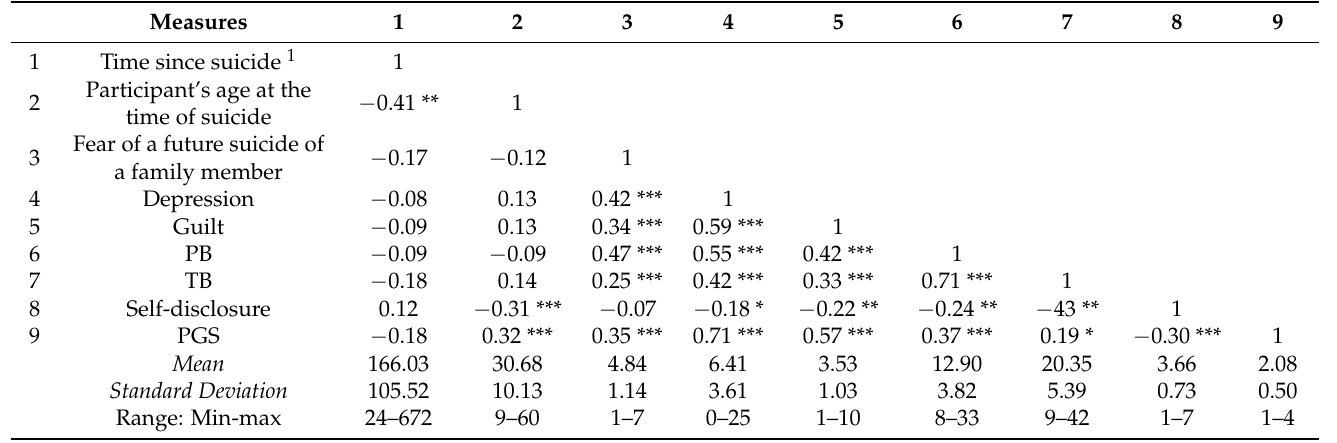
Table 1. Means, standard deviations, and intercorrelations between main study measures ( n =